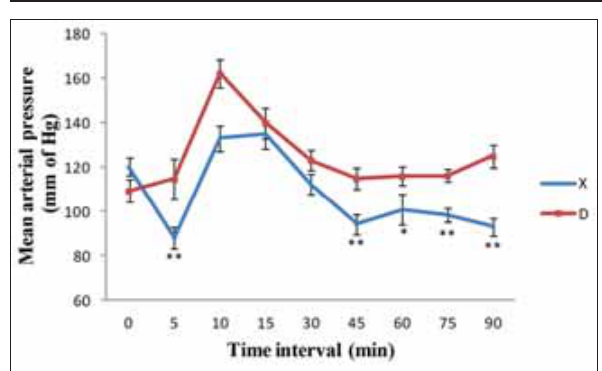
Figure-10: Mean±Standard error values of mean arterial pressure in animals of different groups. *Significantly different from the base value (p<0.05). **Significantly different from the base value (p<0.01).